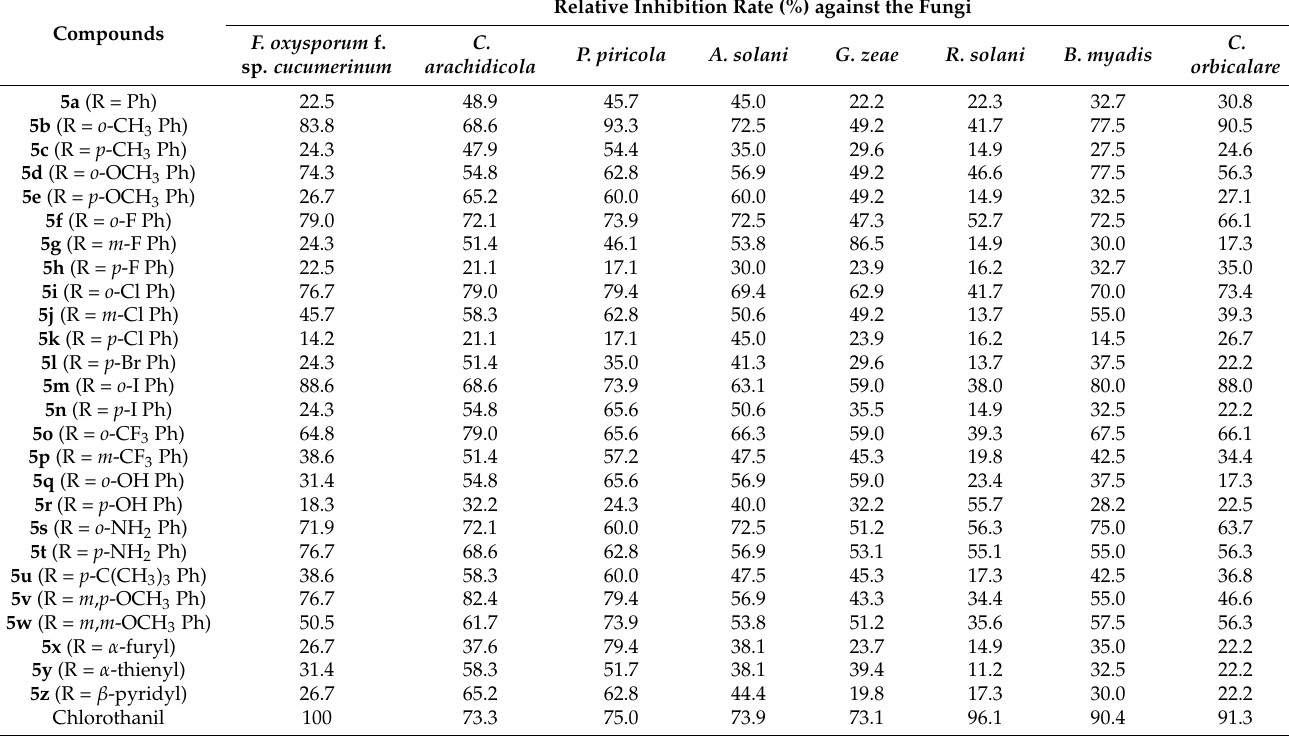
Table 1. Antifungal activity of the target compounds 5a – 5z at 50 µ g/mL. Relative Inhibition Rate (%) against the Fungi Compounds F. oxysporum f. sp.